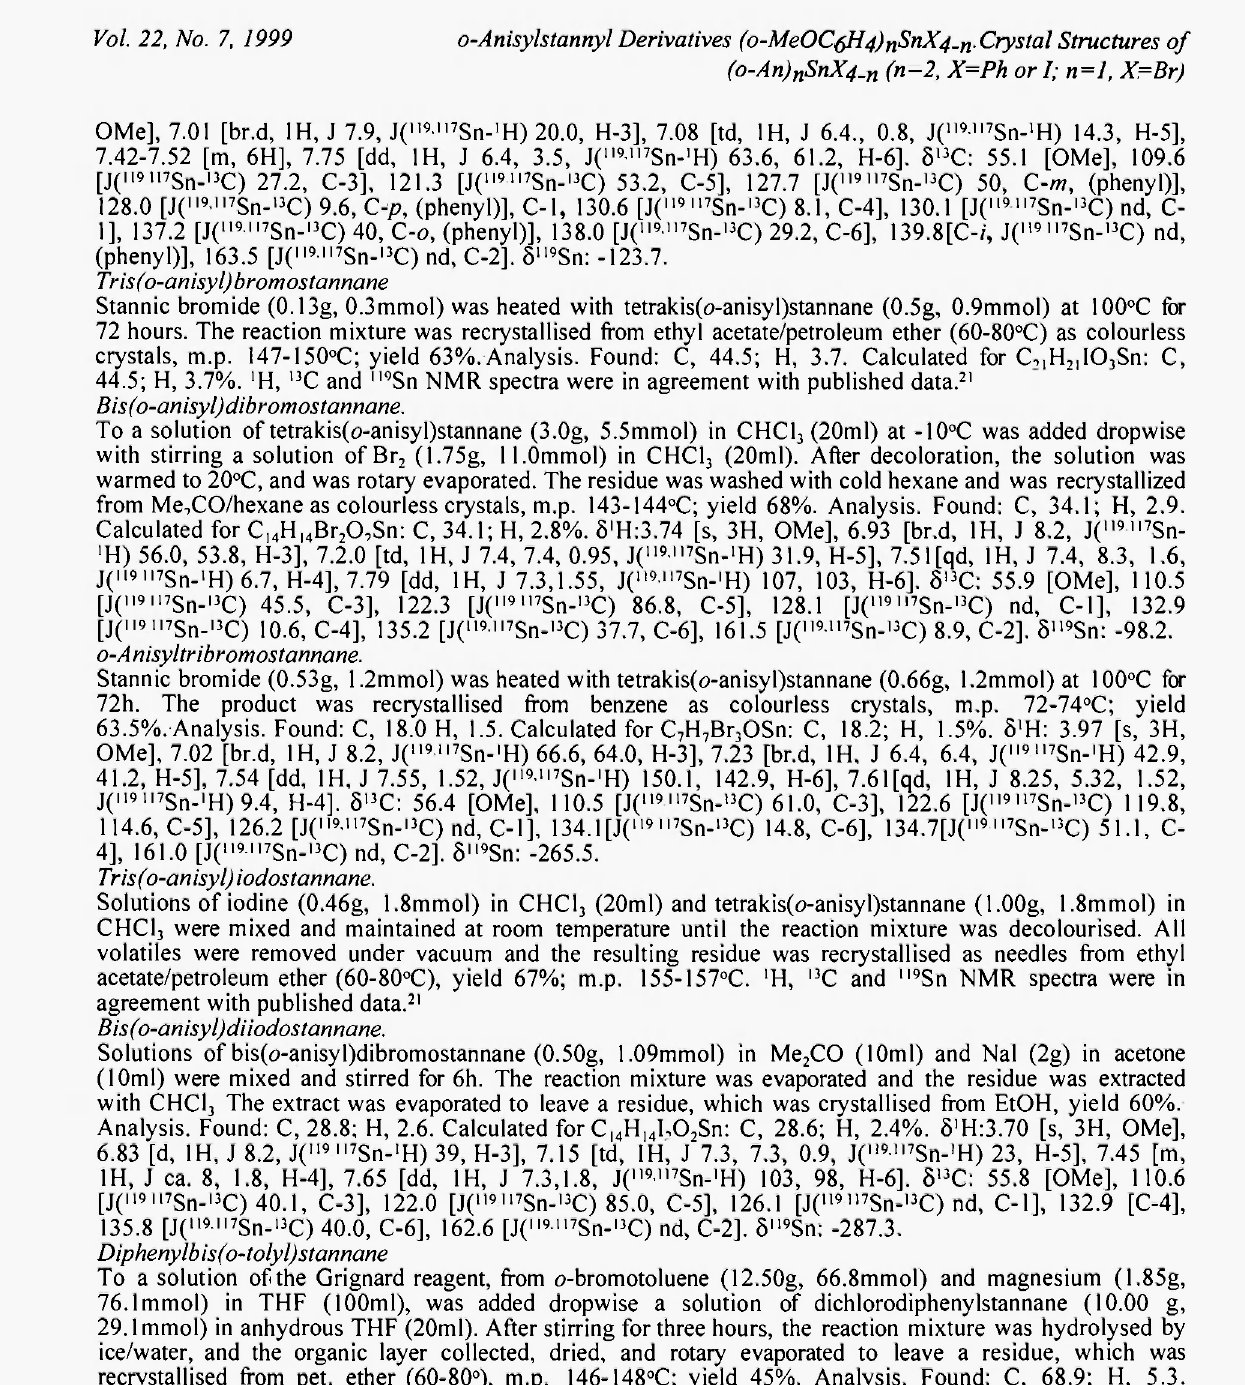
of the products of iodination of diphenylbis(o-tolyl)stannane and bis(o-